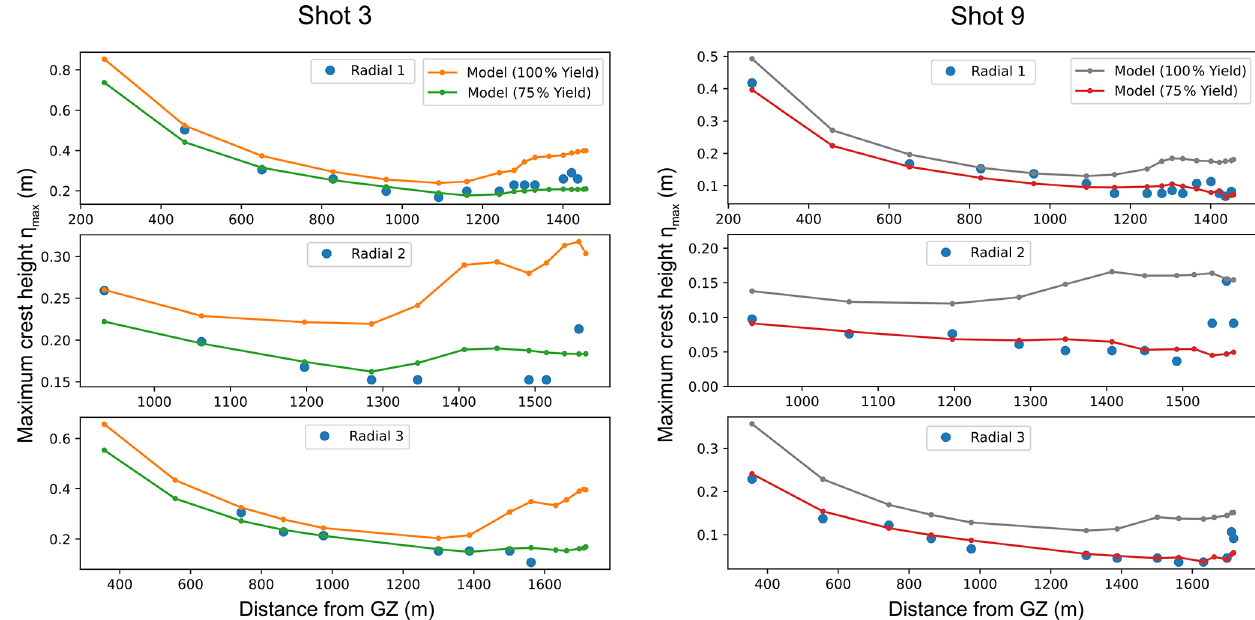
Figure 8. Maximum crest amplitudes at gauge locations for full yield model, fitted model, and experimental